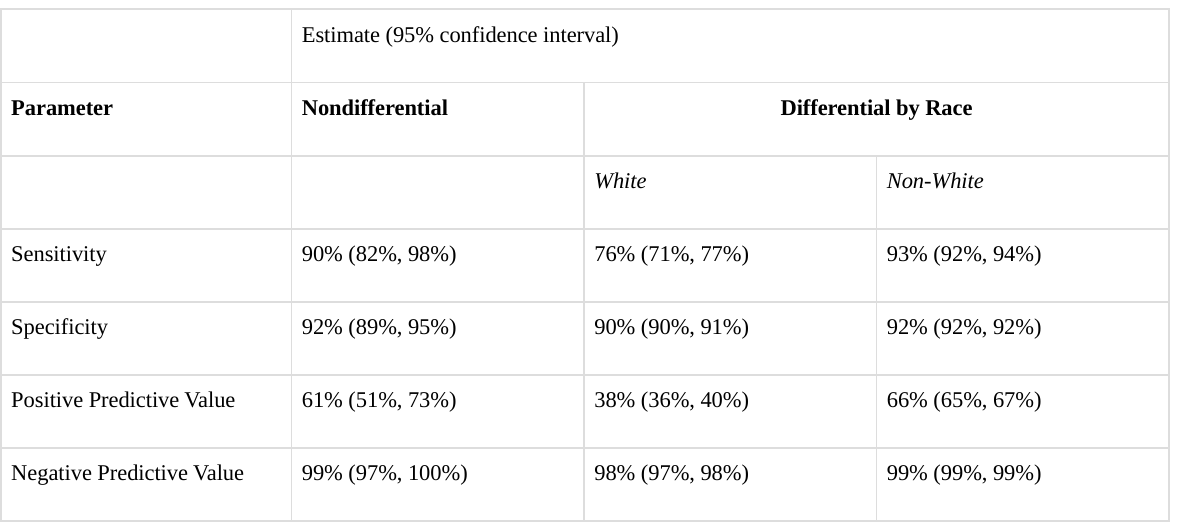
Table 4. Summary of accuracy measures of the EHR indicator of HCV obtained from the validation sub-cohort, nondifferential and differential with respect to